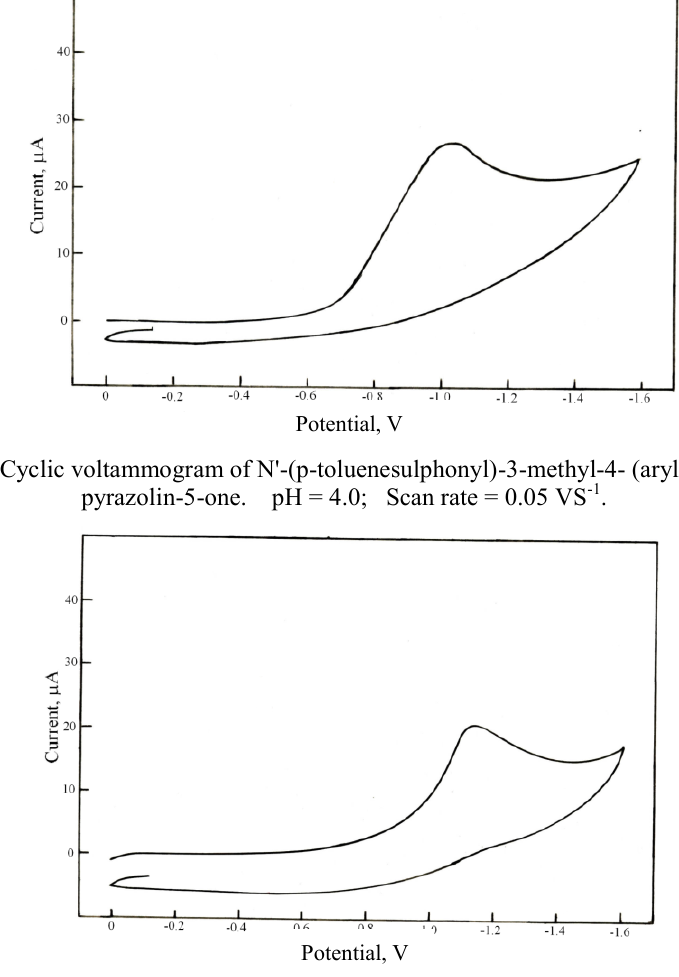
Figure 3: Cyclic voltammogram of N'-(p-toluenesulphonyl)-3-methyl-4- (arylhydrazono) pyrazolin-5-one. pH = 8.0; Scan rate = 0.05 VS -1